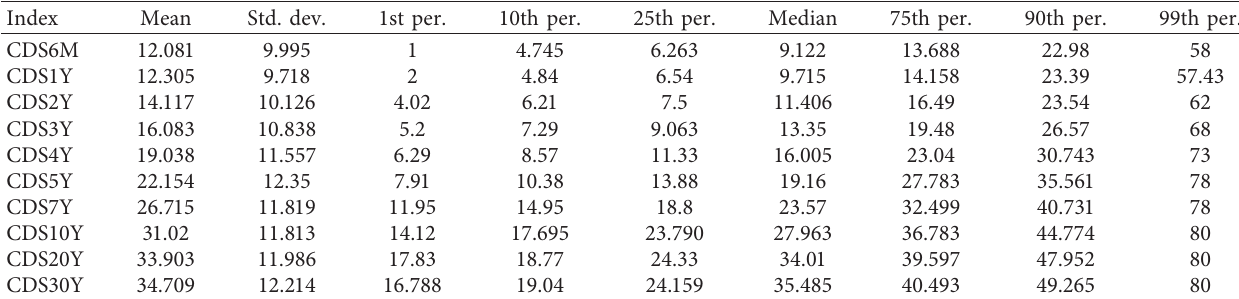
Figure 1: CDS term structure from 2008 to Table 1: Summary statistics for the historical CDS term structure.